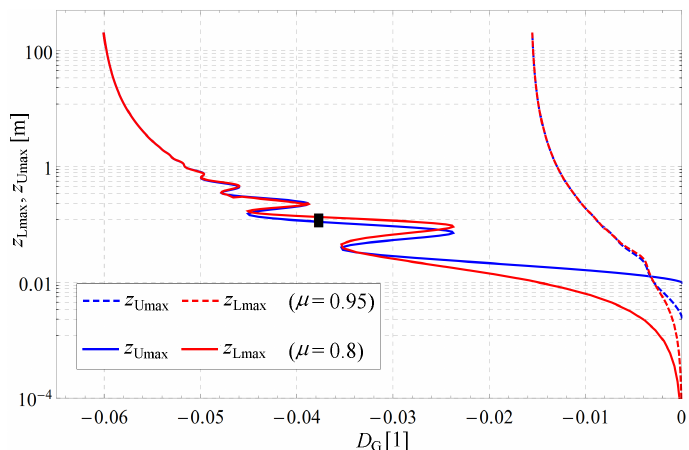
Figure 8. Apex height of the trajectory with different parameters.